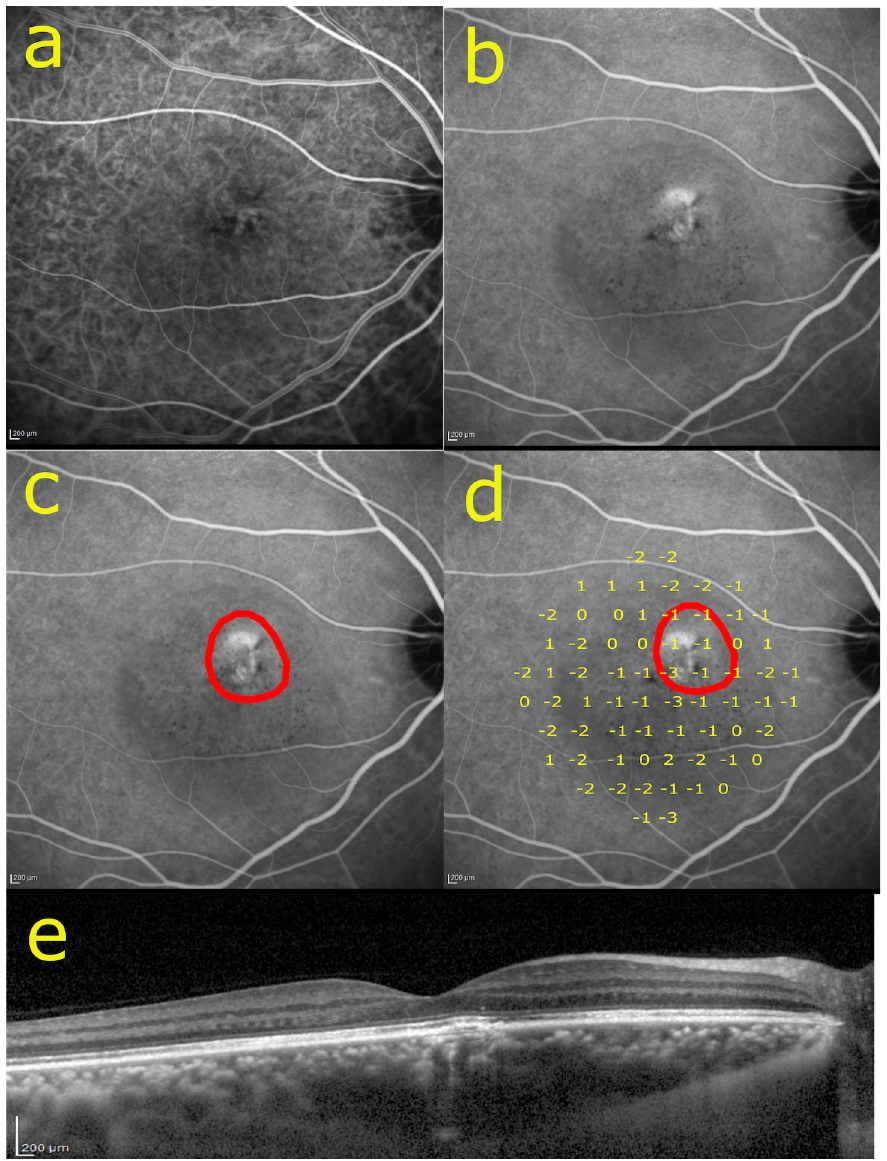
Fig 1. Representative images of identifying CVH by ICGA and superimposing retinal sensitivity. The right eye of a 38-year-old man that had not been accompanied with exudative changes for more than 6 months. ( a ) Early phase of ICGA in an examined eye. ( b ) Late phase of ICGA. CVH was observed nasal superior to the fovea. ( c ) Identification of CVH (red line). ( d ) Retinal sensitivity was superimposed on c . ( e ) EDI-OCT image of the horizontal line scan through the